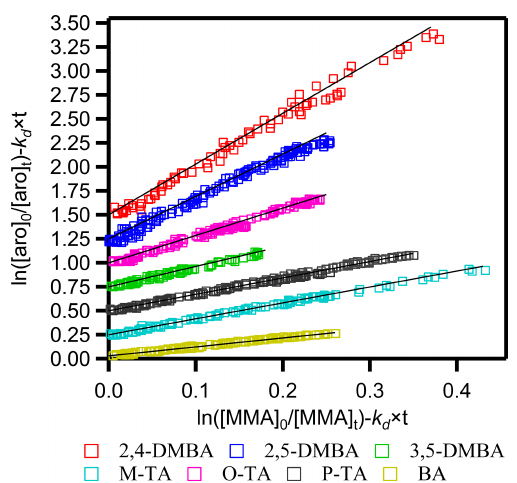
Figure 1. Plots of relative kinetic data obtained from the reaction of aromatic aldehydes (aro) with the NO 3 radical using methyl methacrylate (MMA) as the reference. M-TA, P-TA, 3,5-DMBA, O-TA, 2,5-DMBA and 2,4-DMBA were shifted 0.25, 0.5, 0.75, 1.0, 1.25 and 1.5, respectively, for